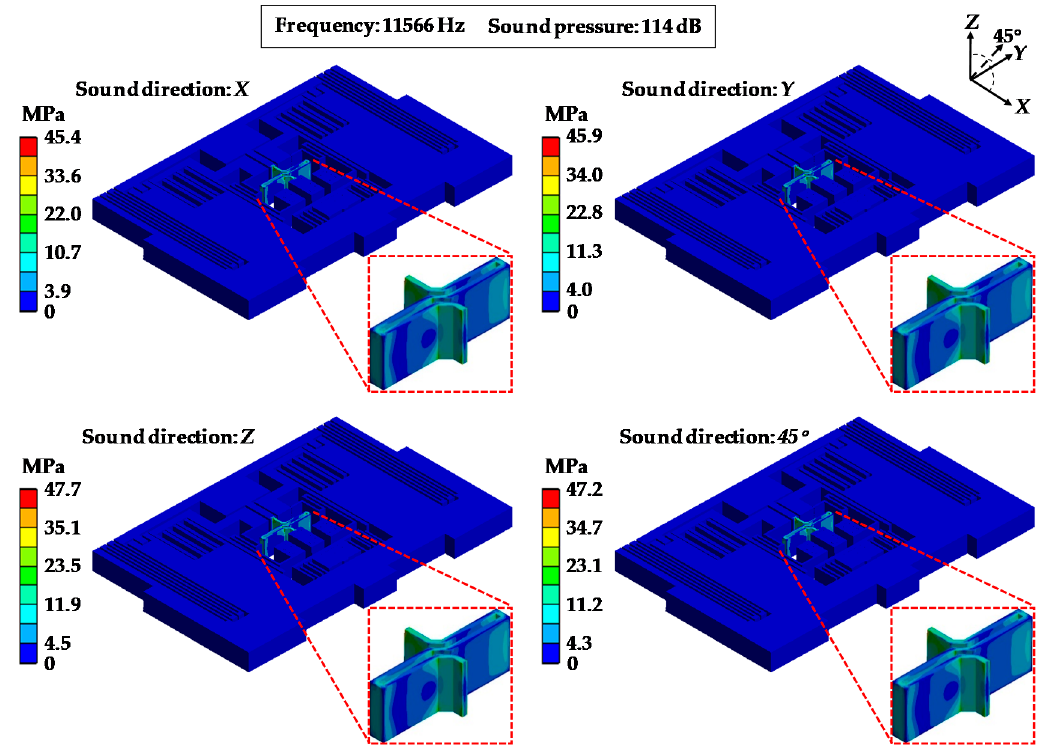
Figure 13. Equivalent stress of MPU6050-Y under acoustic injection in different sound directions.